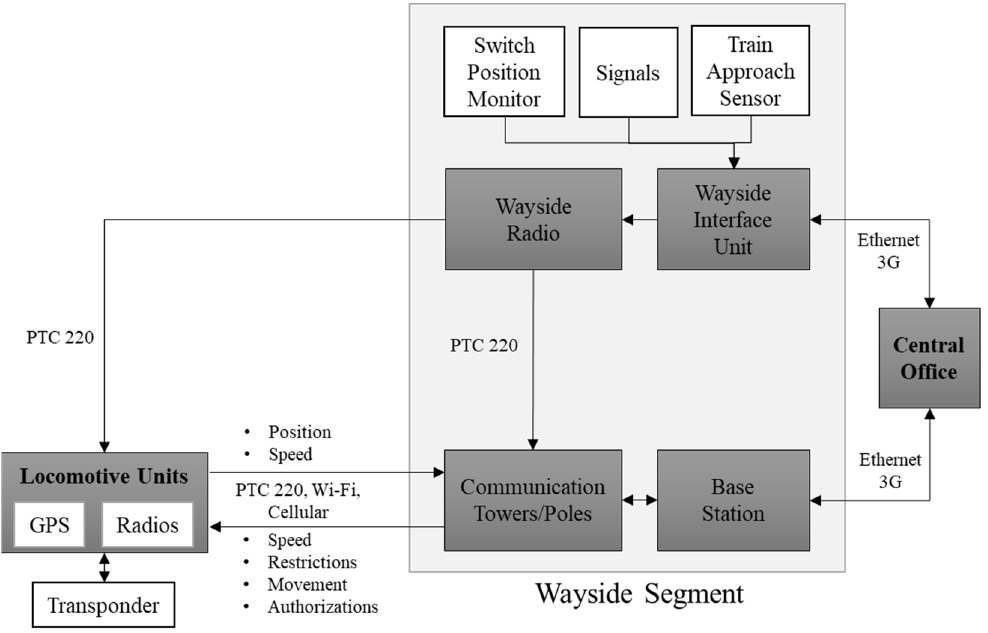
Figure 4. Architecture of a PTC system.